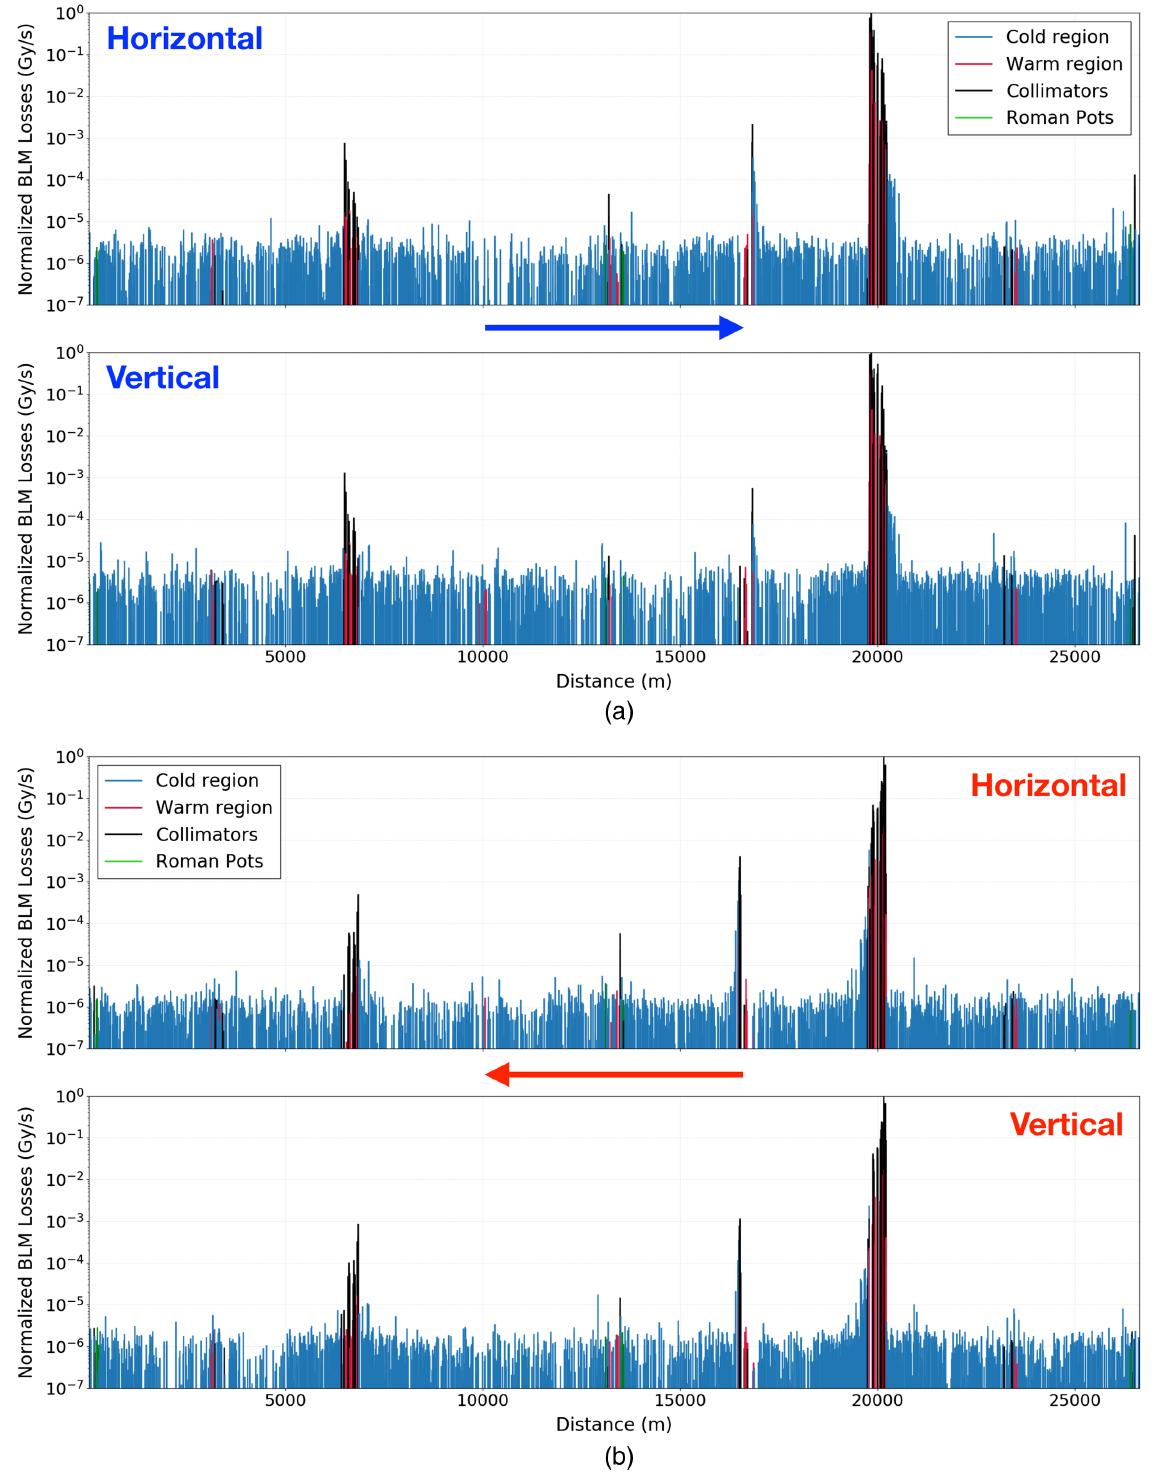
FIG. 19. Loss maps generated on 13-04-2018 to validate the BLM collimator alignment at flattop for (a) beam 1, and (b) beam 2, indicating the beam direction by the arrow in each